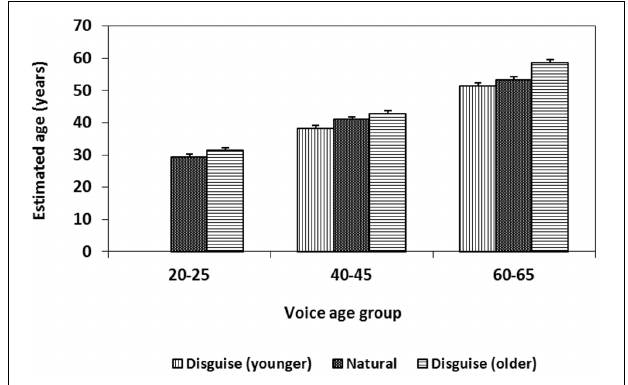
FIGURE 3 | Effects of voice disguise to sound younger or older than normal on perceived age over three age groups of speakers. Error bars indicate the standard error of the mean